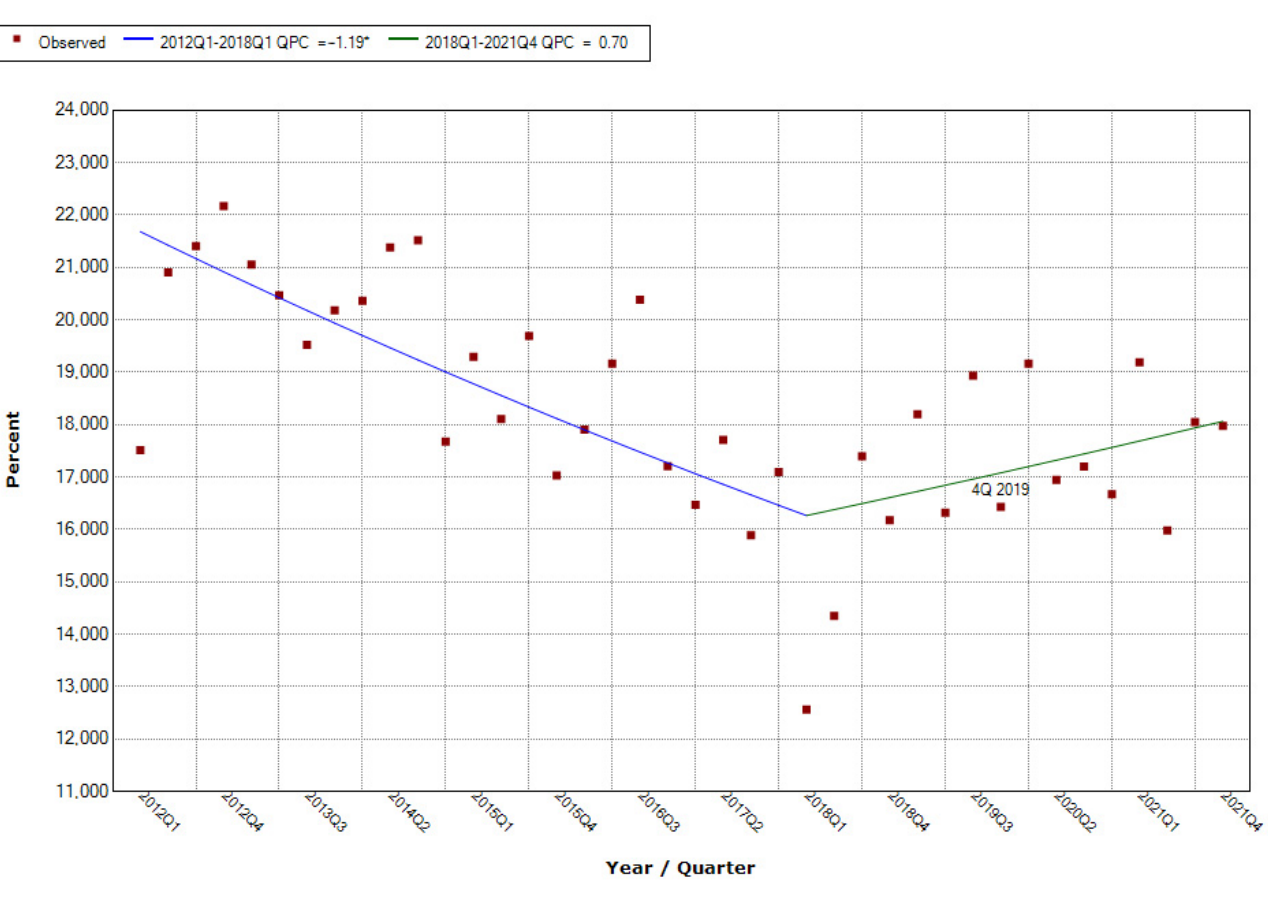
Figure A26. Percentage of products containing vitamin B6 in individual quarters in the period from 2012 to 28 November 2021. Joinpoints mark trend turning points. The date above the observation indicates the moment of publication of the scientific opinion/resolution.